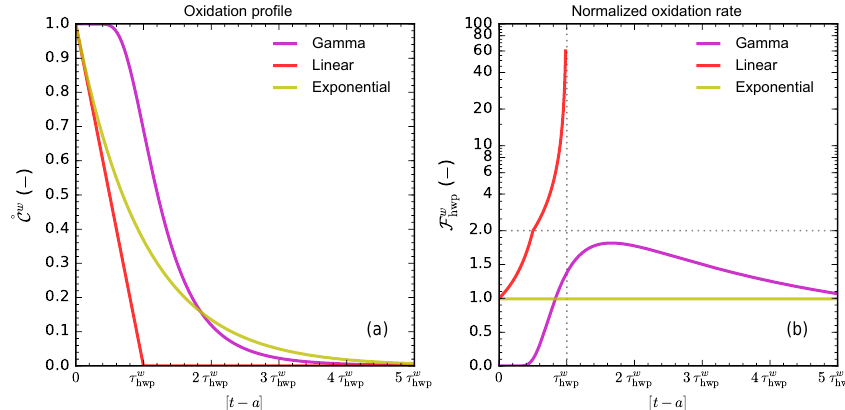
Figure 3. Functional forms possible for the harvested wood products oxidation (Sect. 2.3.3). They are shown as the oxidation profile of a unit pool of wood product (left-hand panel) and as the corresponding normalized yearly oxidation rate (right-hand panel). The former is denoted ◦ C and the latter is exactly the function F hwp . They are linked by the following relationship: F w by